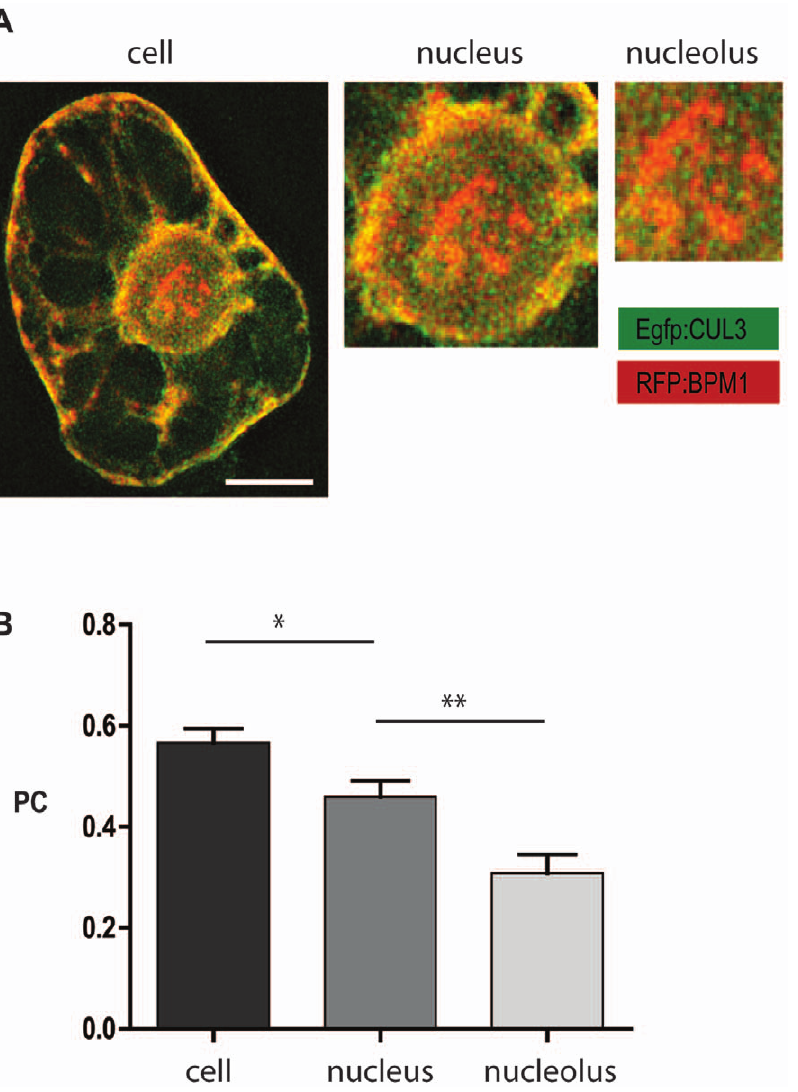
Figure 4. Co-localization analysis of BPM1 and CUL3 in the tobacco BY2 cells. BPM1 and CUL3 signals display a complete overlay at the level of the entire cell, including the nucleus and nucleolus (A). Pearson’s coefficient (PC) reflects a reduction in protein co-localization level in the nucleus and nucleolus (B). N=18. Bar is 10 m m.